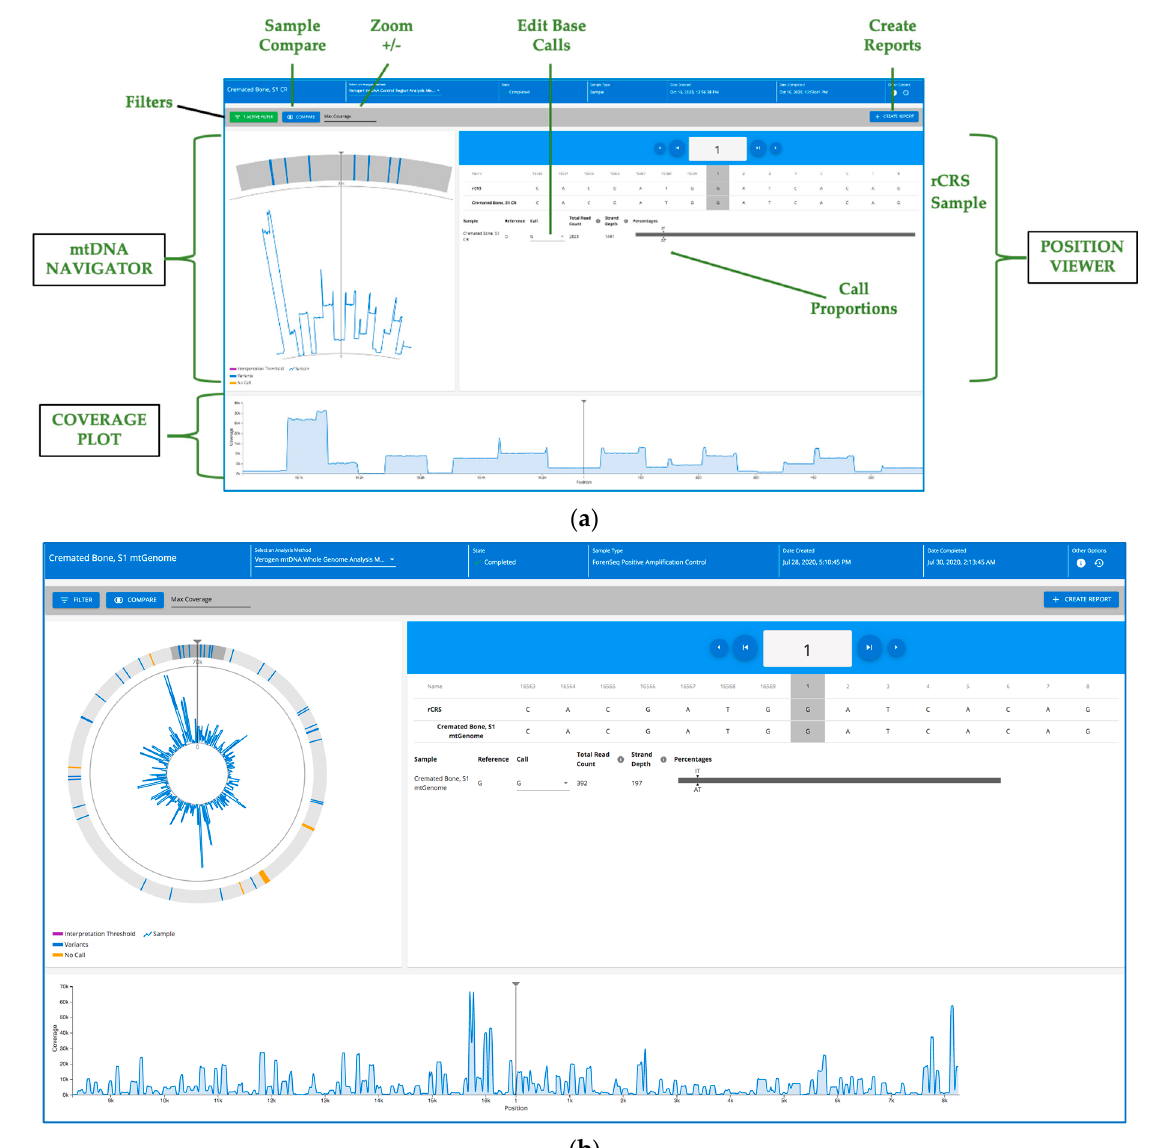
Figure 2. mtGenome data visualization of a mock casework sample as displayed in ForenSeq universal analysis software (UAS). ( a ) “Sample details” view zoomed to control region only; ( b ) zoomed out to display the whole mtGenome. The three main sections of the UAS sample details view are labeled in ( a ) and shown in ( b ): mtDNA navigator (upper left), Position Viewer (upper right) and coverage plot (bottom); a subset of software options and tools are also labeled in ( a ). ( a ) Commercially cremated bone sample S1 view of control region with 100% coverage and 100% variant calls reported. Variants are indicated by blue-colored tick marks in the mtDNA navigator; zero orange-colored tick marks are displayed, indicating complete coverage and zero “no calls”, which would render in orange (see ( b )). ( b ) Bone sample S1 zoomed out view of entire mtGenome, as compared to ( a ) with 98% coverage due to “no calls” in eight regions (see Table 1), which are visible as orange-colored tick marks in the mtDNA navigator circle. Notes: 100% control region variant concordance was observed between both kits for bone sample S1; base call “C” was present at position 16,183 at 6.3% (below default AT) in control region run and at 6.3% (above default AT) in mtGenome run (Table 1).